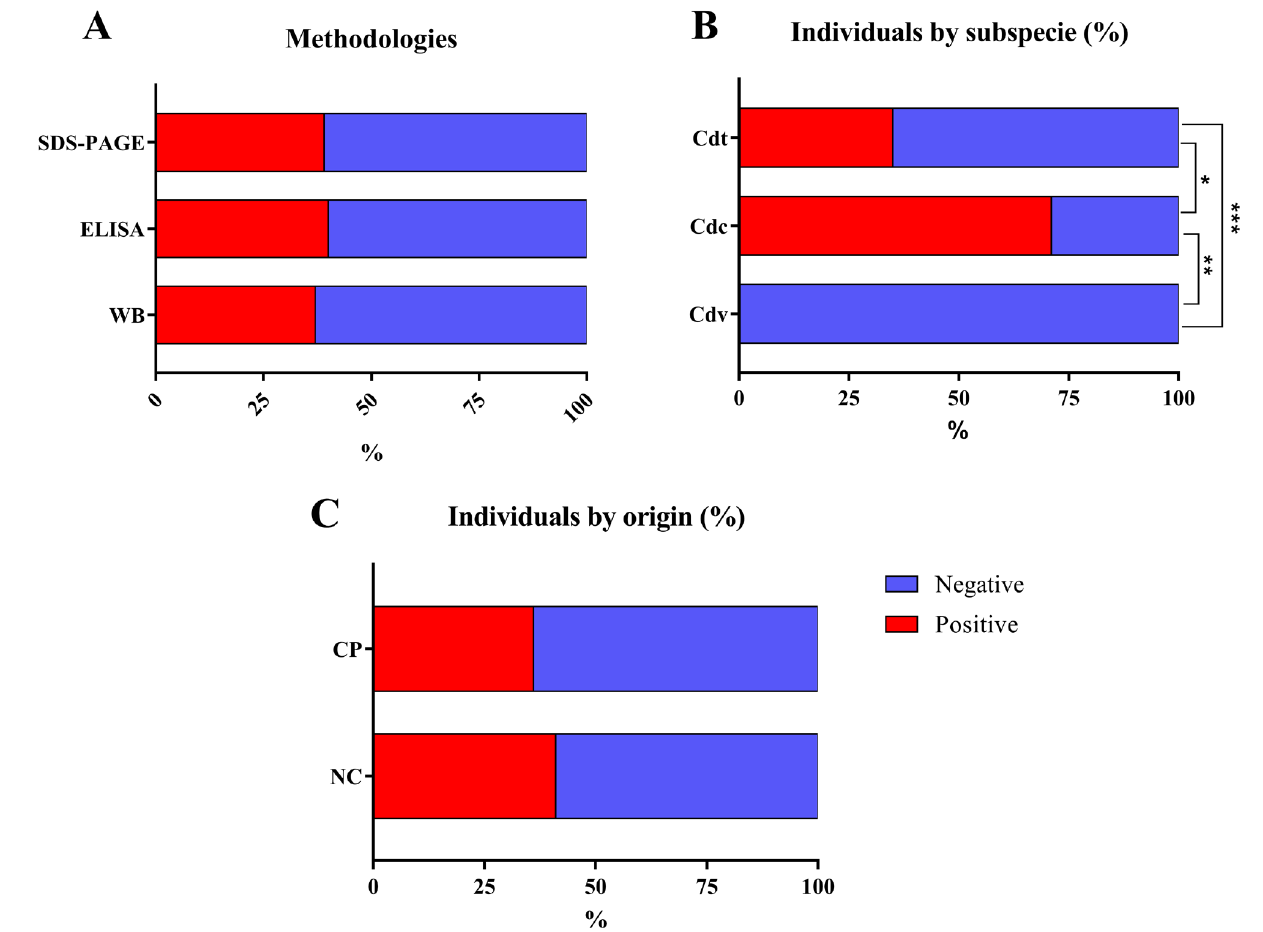
Figure 2. Percentage of C. durissus crotamine-positive (red) and crotamine-negative (blue) identified by: (A) each methodology, (B) according to subspecies and (C) to the origin of snakes. WB: western blotting; Cdt: C. d. terrificus ; Cdc: C. d. collilineatus ; Cdv: C. d. cascavella ; CP: captivity snakes; NC: newcomer snakes. *p < 0.0003; **p < 0.0001; ***p <